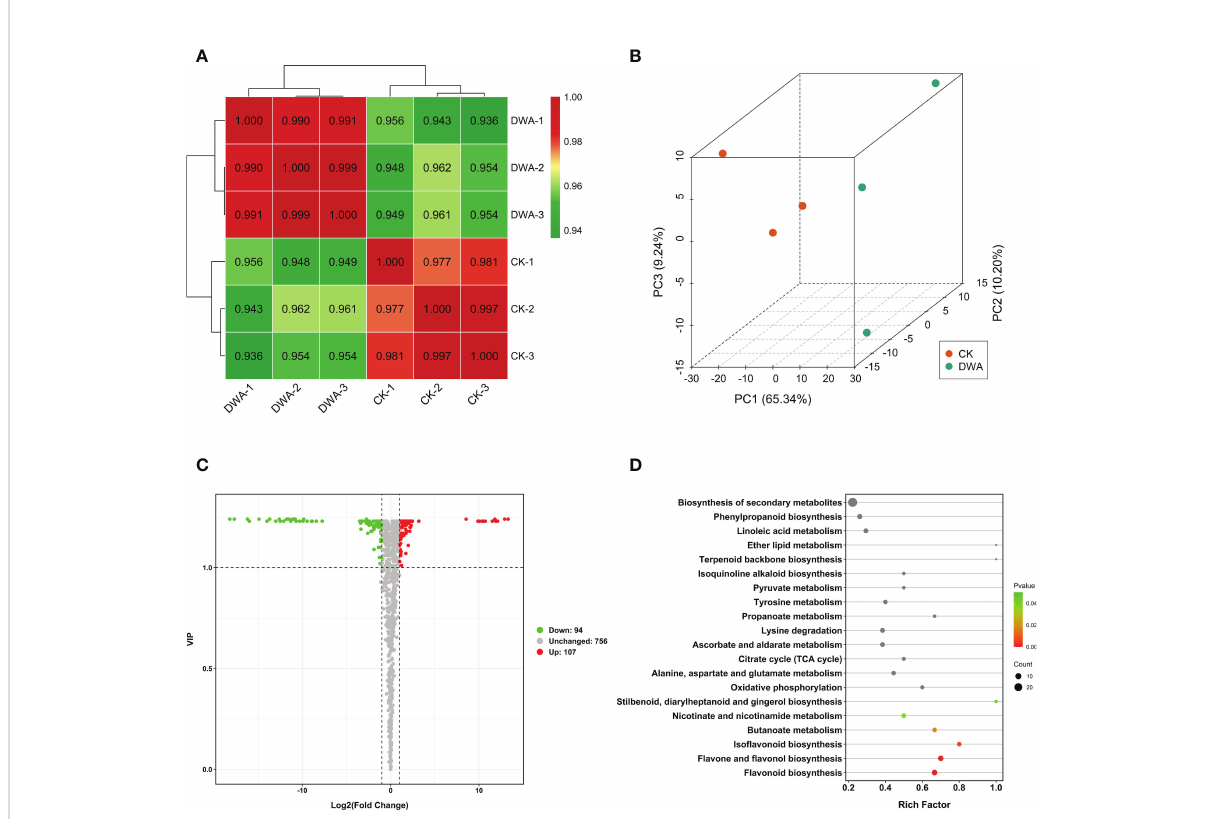
FIGURE 3 Metabolome analysis of fl owering Chinese cabbage under uniconazole treatment. (A) Correlation pro fi le between the samples. (B) Principal component analysis of metabolome samples. (C) Volcano map of DAMs. (D) Kyoto Encyclopedia of Genes and Genomes pathway enrichment of DAMs. DAMs, differentially accumulated metabolites; CK, 0 mg·L -1 uniconazole (pure water); DWA, 100 mg·L -1